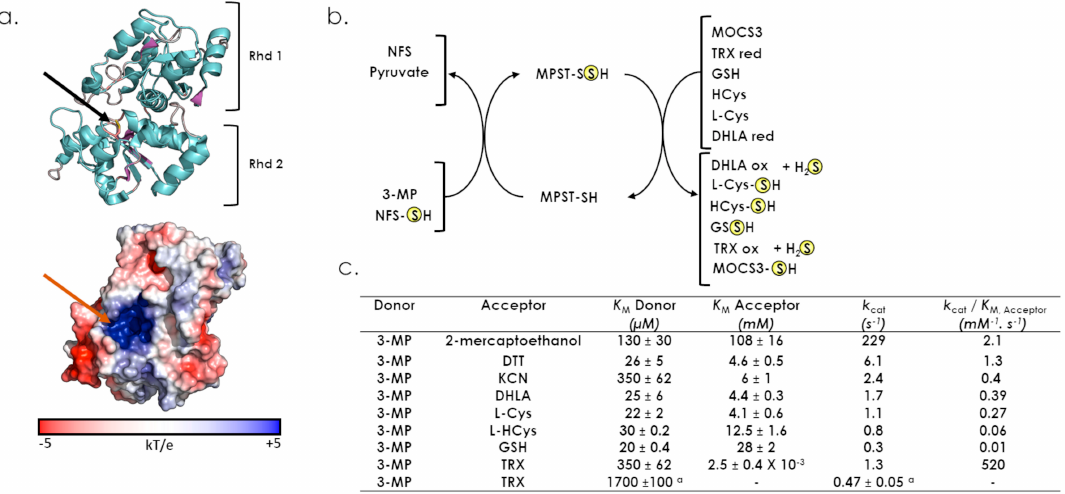
Figure 7. Structural and catalytic properties of MPST. ( a ) Cartoon and surface representations of the MPST structure (PDB 4JGT). The active site cysteine is represented in stick and indicated by a black (cartoon) or a red (surface) arrow. ( b ) describes sulfur donors or acceptors for the MPST. ( c ) Steady-state kinetic parameters for the 3-mercaptopyruvate sulfurtransferase activity of MPST ([54], except for a [25]).